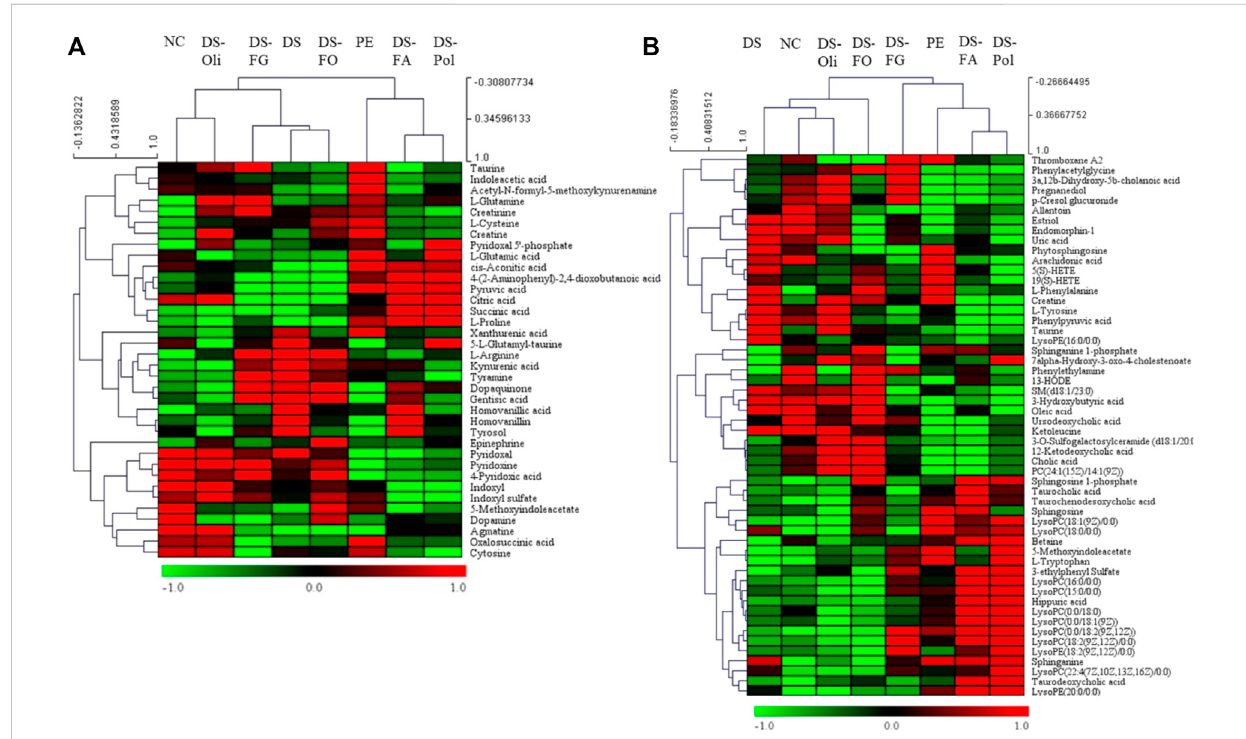
FIGURE 4 Heat maps and hierarchical clustering analysis (HCA) of potential biomarkers in urine (A) and serum samples (B) . The color from red to blue referred to higher and lower average content changes of the potential biomarkers, respectively. The rows represent different metabolites, and the columns represent different